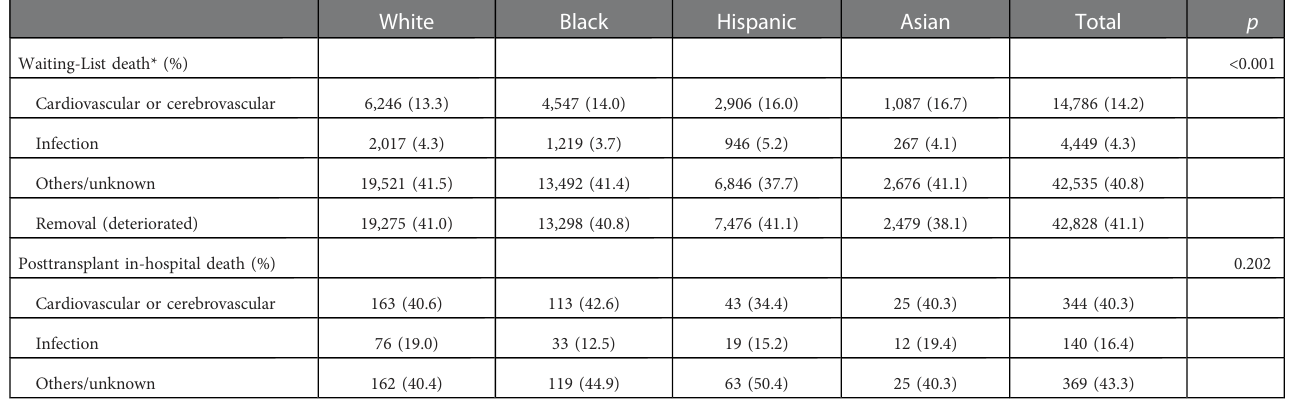
TABLE 4 Distribution of causes of waiting-list death* and posttransplant in-hospital